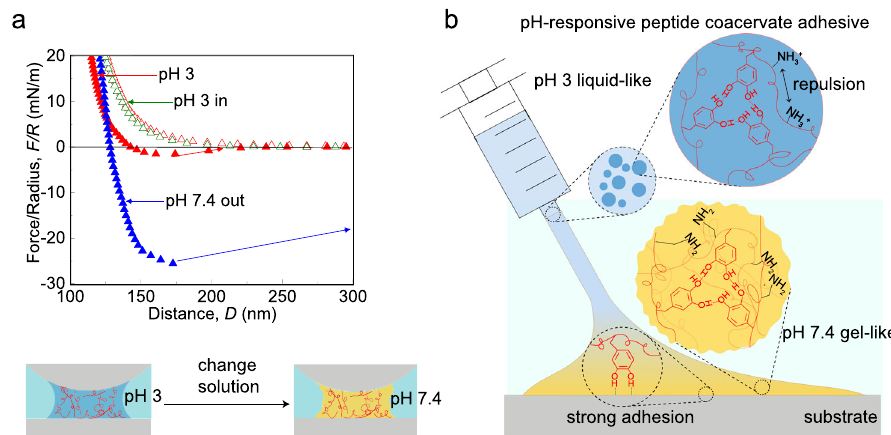
Fig. 6 | GK-16* based pH-responsive coacervate adhesives. a SFA measurements on GK-16* coacervate (2mg/mL, 100mM ionic strength) indicate a liquid-to-gel transition by changing the solution pH from 3 to 7.4. b A schematic of pH-